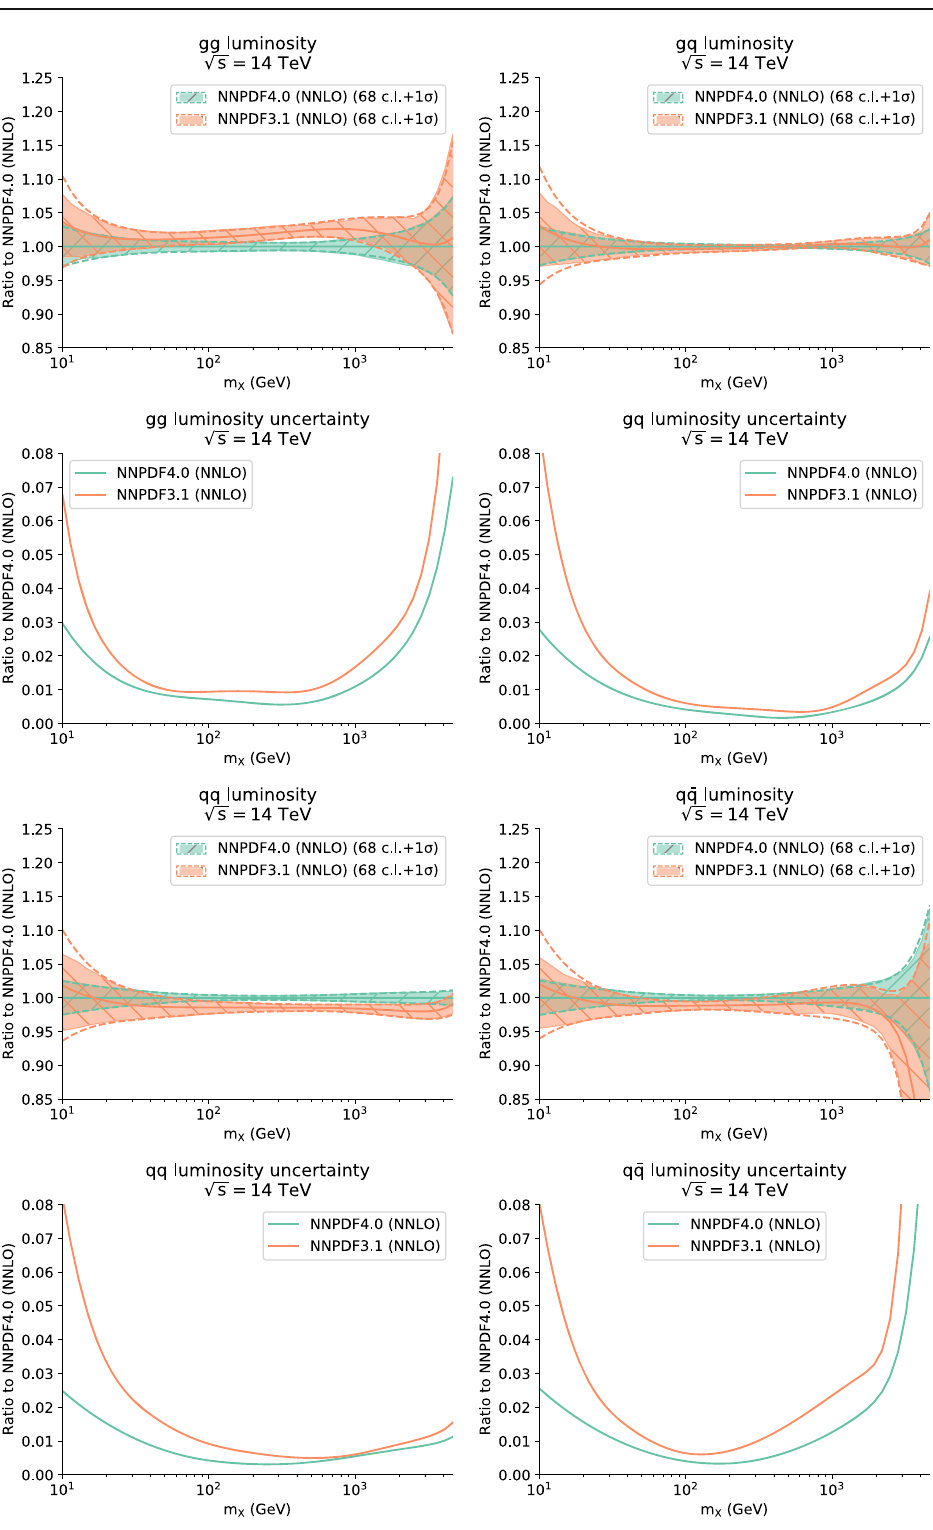
the final-state rapidity y . The ratio to the NNPDF4.0 central value and the relative one-sigma uncertainty are shown for each parton combina-